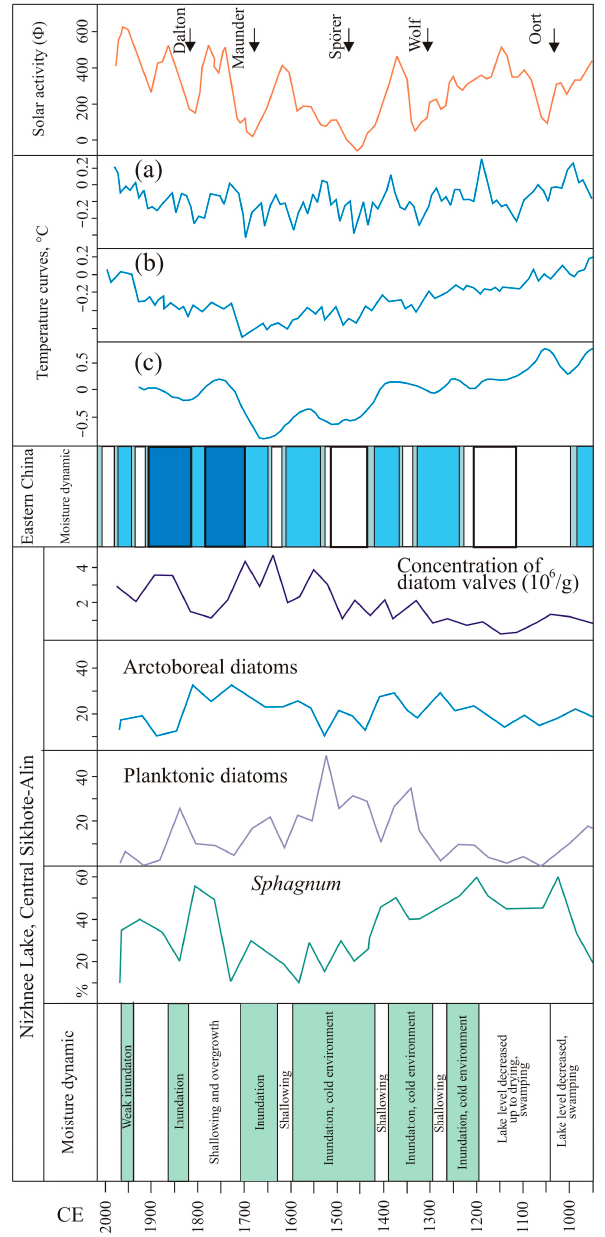
Figure 8. Evolution of Nizhnee Lake (site 9 on Figure 2) and changes of diatom proxies during the last millennium. Solar activity fluctuations reconstructed based on 10 Be measurements in Antarctica ice [96]. Temperature curves: ( a , b ) reconstruction of temperature anomalies for the Northern Hemisphere from average during 1951–1980 CE [89] and 1961–1990 CE [90]; ( c ) Chinese temperature anomalies (sigma units) [94,95].